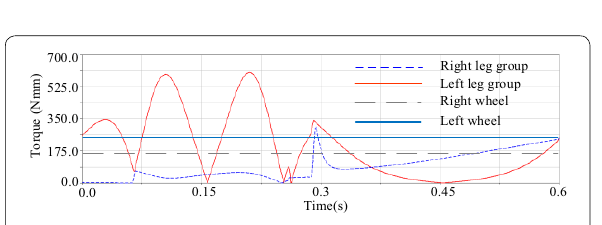
Figure 15 Motor output